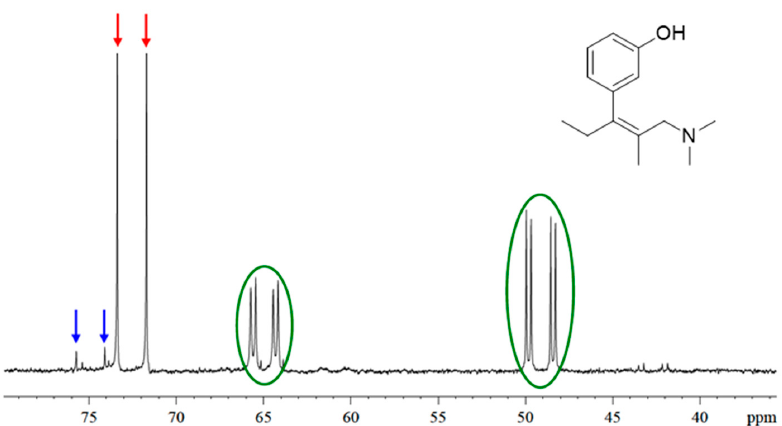
Figure 23. 31 P{ 1 H} NMR spectrum of a solution of [Rh(DIPAMP)(MeOH- d 4 ) 2 ]BF 4 and (3-[(2 R ,3 S )-1-(dimethylamino)-2-methylpentan-3-yl]phenol (rhodium: substrate = 1:10). About 34% of the signal intensity (red arrows) is due to the doublet of the trinuclear complex [Rh 3 (DIPAMP) 3 ( µ 3 -Cl) 2 ]BF 4 . The signal set highlighted with blue arrows (2% of signal intensity) is due to the dinuclear complex [Rh 2 (DIPAMP) 2 ( µ 2 -Cl) 2 ]). Highlighted in green is the substrate complex [Rh(DIPAMP)(substrate)]BF 4 .